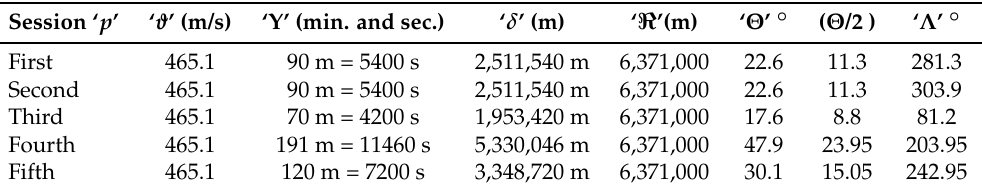
Table 3. Computations results of the five